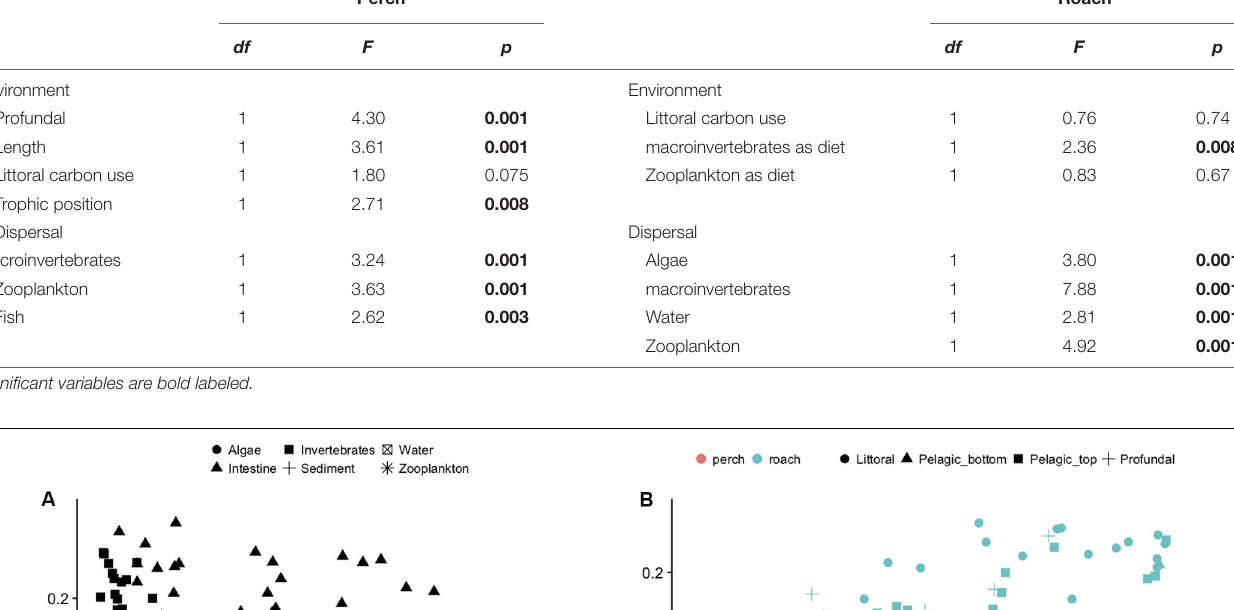
TABLE 1 | ANOVA test the significance of each variable in the estimated environmental and dispersal factors explaining the variance of intestinal microbial communities from pRDA analysis in perch and roach. Perch Roach